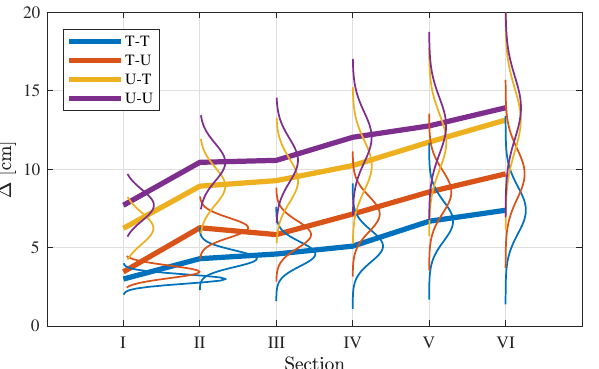
Figure 6. Path difference by large intestine section, S , averaged over all reconstructions for the same video as in Figure 5.